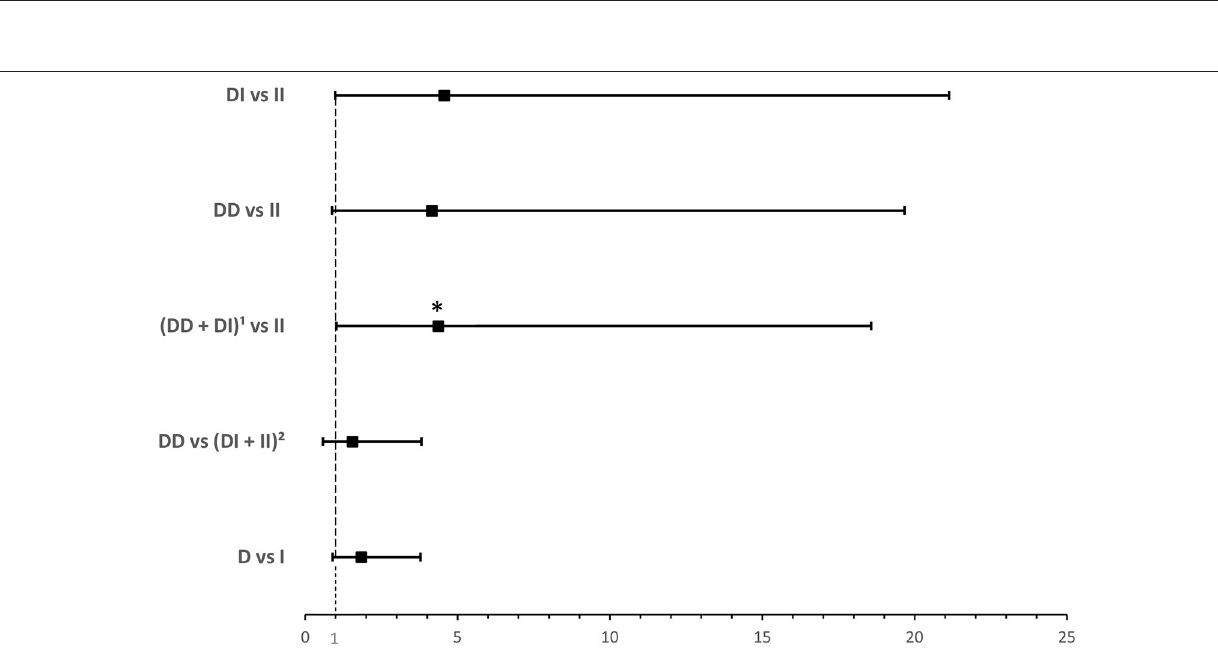
to the severity of COVID-19 (34). Further data are needed to resolve this